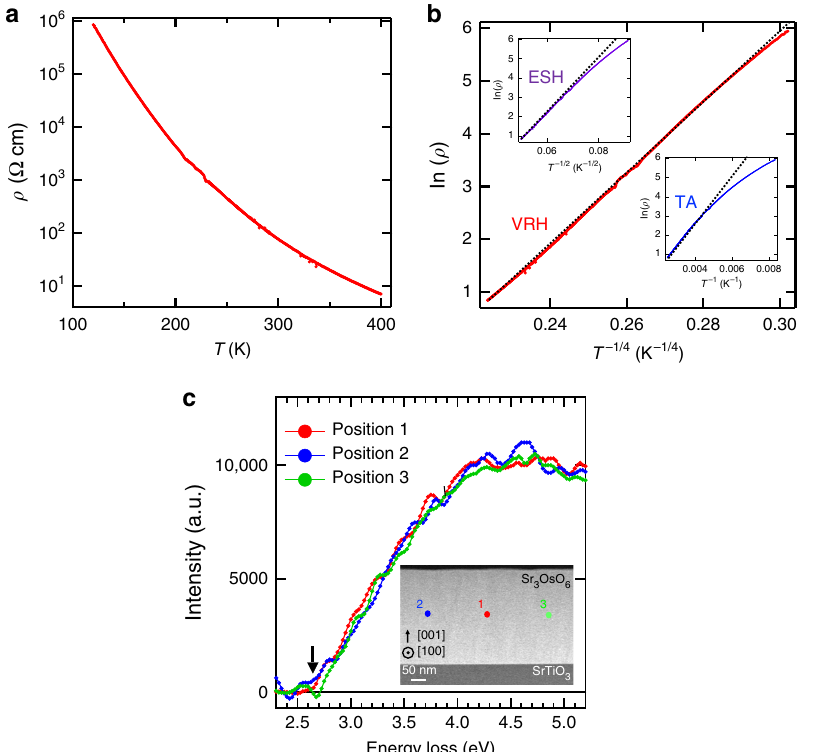
Fig. 3 Resistivity and dielectric properties of a Sr 3 OsO 6 fi lm. a ρ – T curve for a Sr 3 OsO 6 fi lm. b Logarithm of ρ versus T − 1/4 plot, corresponding to the VRH model. The insets of b show the logarithm of ρ versus T − 1/2 and T − 1 plots, corresponding to the ESH and TA models, respectively. The black dashed lines in b are guides to the eye. c The EELS spectra of a Sr 3 OsO 6 fi lm measured at the spots indicated in the cross-sectional STEM image (inset). The background was corrected with a power-law fi t from 2 to 2.3